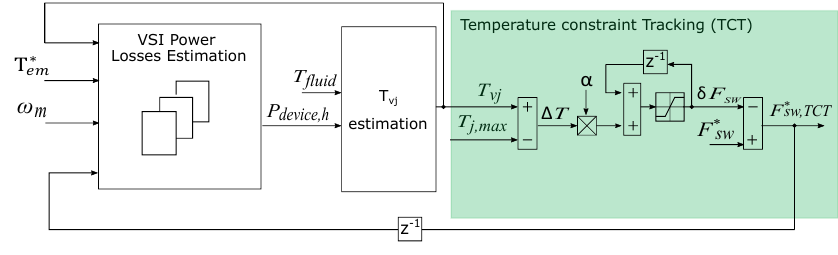
Figure 4. Block diagram of the proposed TCT control